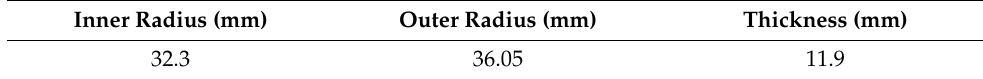
Table 3. Dimensions for Type-2 quadrupole wound coils.